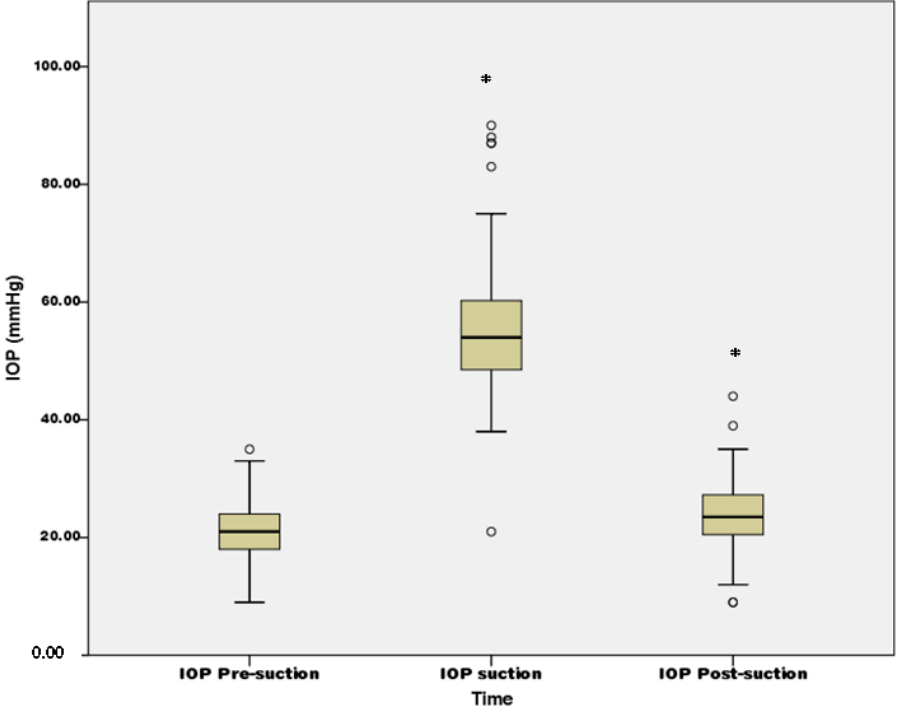
Figure 3. Box plot of intraocular pressure change during femtosecond laser-assisted cataract surgery, IOP: intraocular pressure, * denotes significant difference of intraocular pressure compared to presuction intraocular pressure.